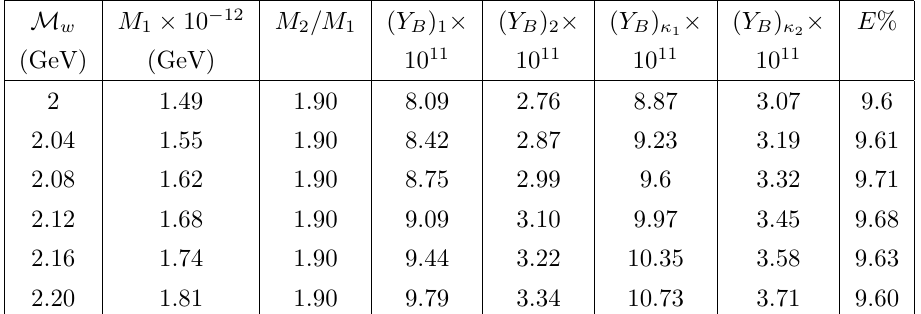
). ( Y B ) 1 i(cid:11) and ( Y B ) (cid:20) are the values of (cid:12)nal baryon 1 2